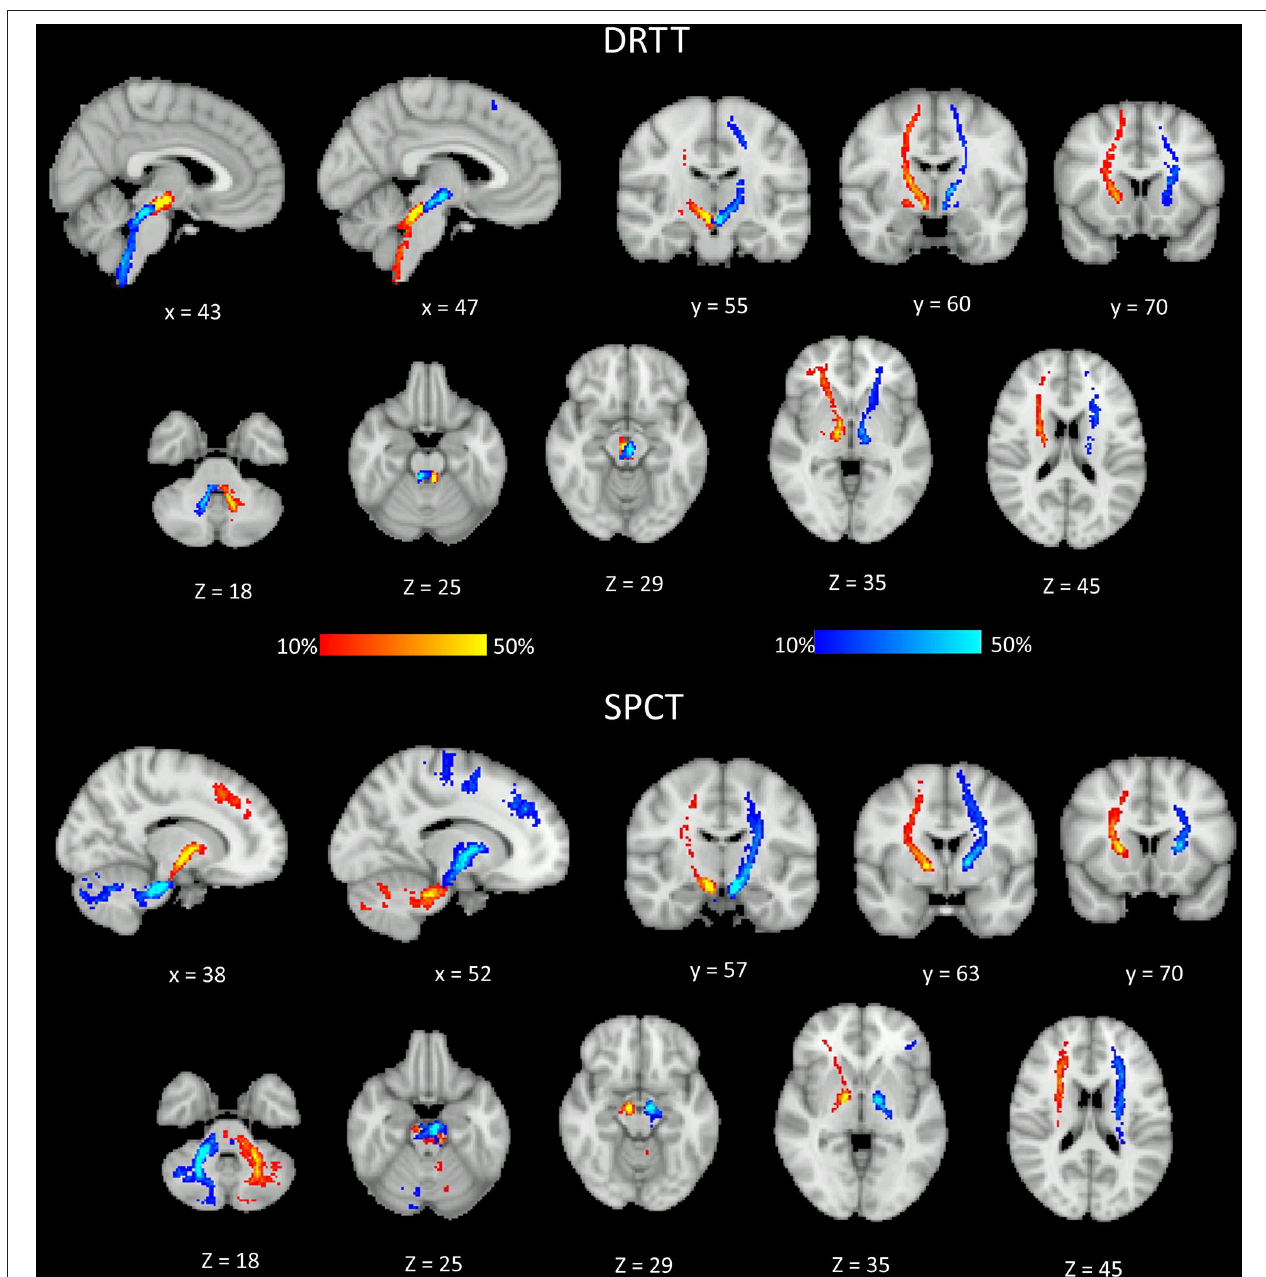
FIGURE 4 | Different sections of the Montreal Neurological Institute (MNI) brain showing the probability (in percent) of the dentato-rubro-thalamic tract (DRTT) and the subthalamo-ponto-cerebellar tract (SPCT) in the Parkinson’s disease (PD) group. The display range is set to 10–50%, hence areas of the brain showing yellow and light blue colors have at least 50% of participants’ tracts passing through those